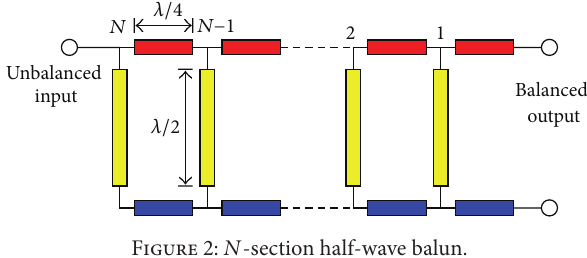
Figure 2: 𝑁 -section half-wave balun.